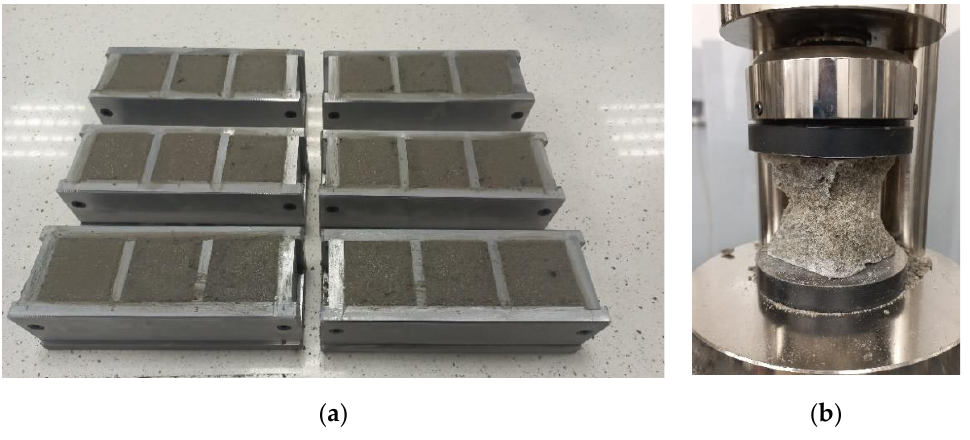
Figure 1. ( a ) One set of fresh mortar samples; ( b ) compression